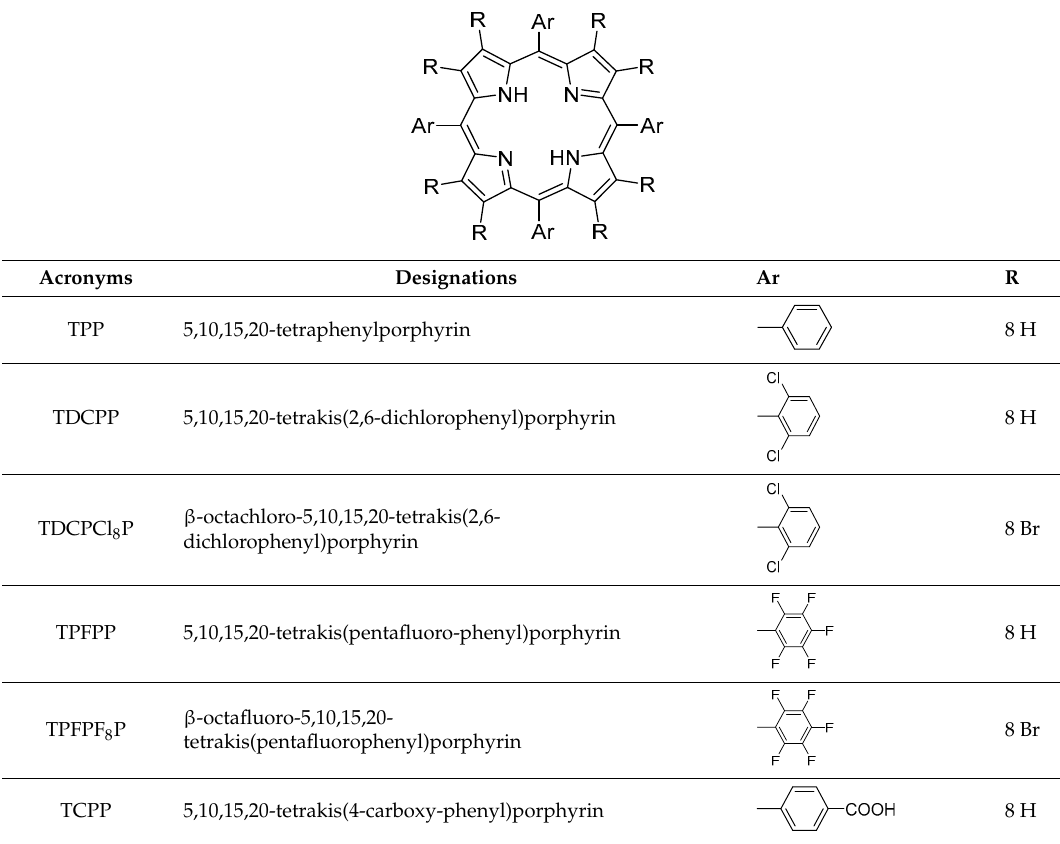
Table 2. meso -Tetrasubstituted porphyrins with and without substituents in the β -positions